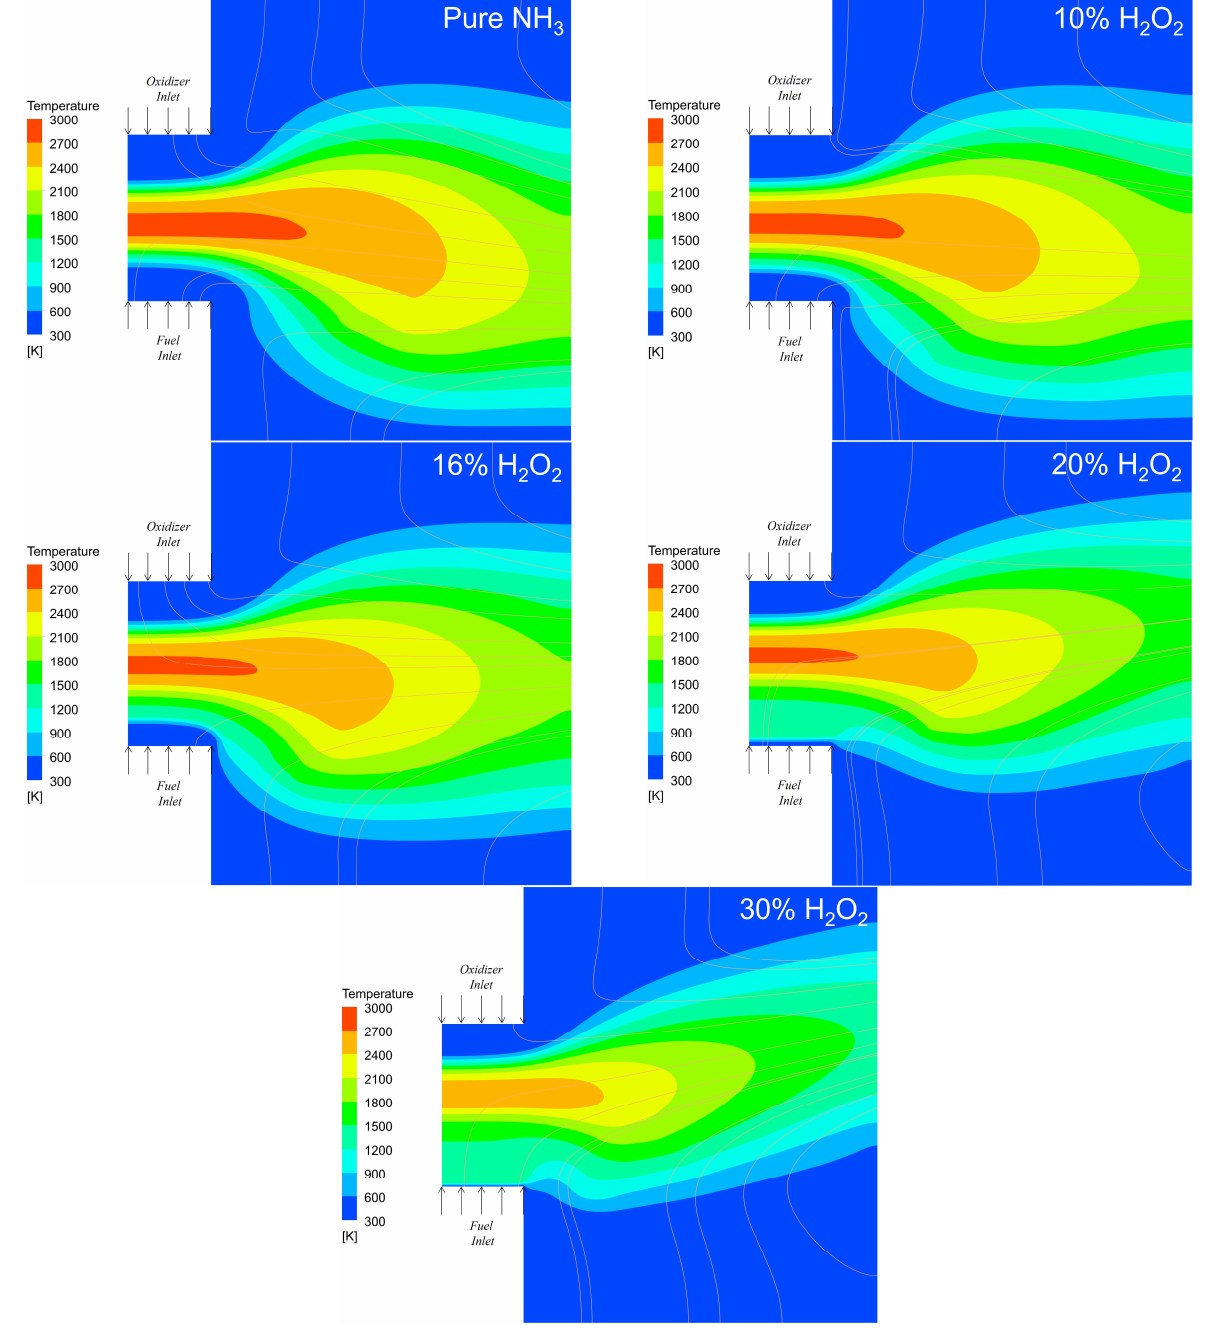
Figure 4. Temperature distributions in the flow field for the five NH 3 -H 2 O 2 /O 2 flames with varying H 2 O 2 addition under consideration.